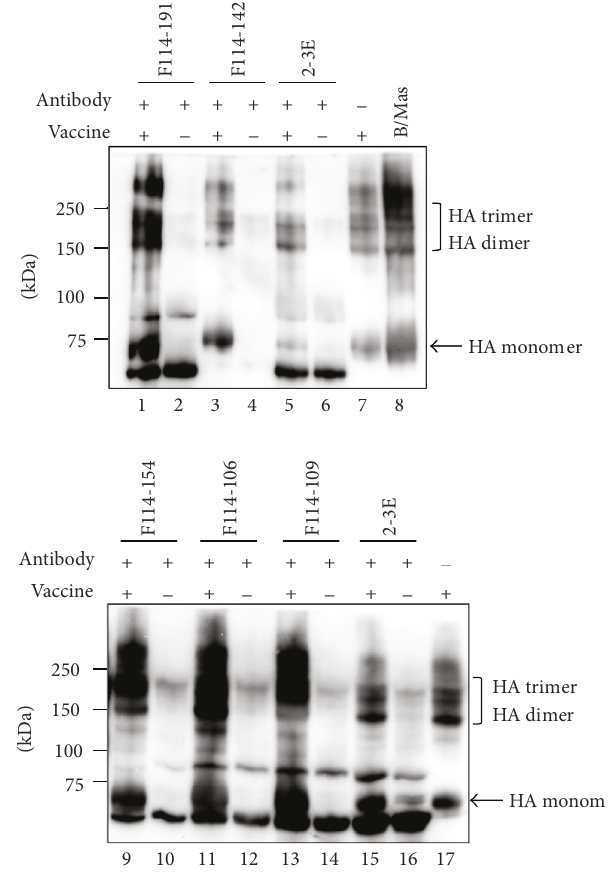
Figure 9: Western blotting of virus components complexed with Fab-PP form of Abs. Four type 2 Abs, F114-191, F114-142, F114- 154, and F114-106, and one type 3 Ab F114-109 were analyzed. Vaccine was B/Massachusetts/2/2012. 2-3E, anti-VP4 of rotavirus Ab was a negative